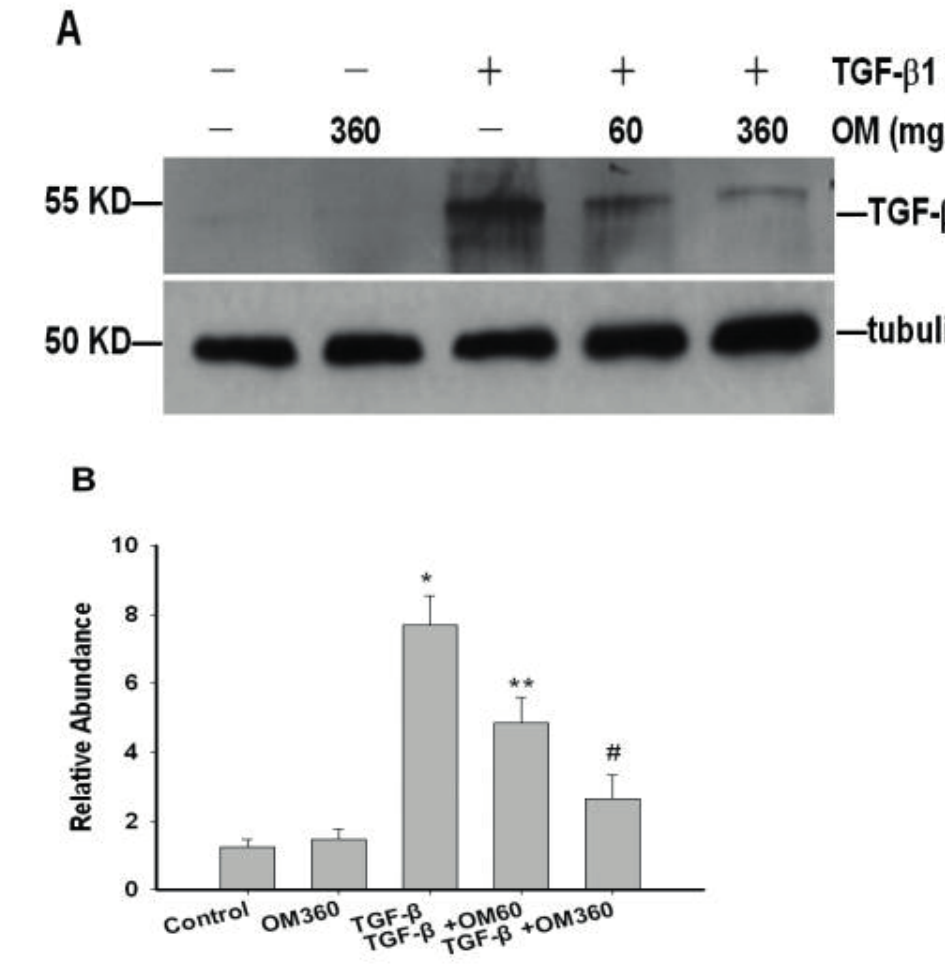
FIGURE 7 - OM treatment attenuated the expression of TGF- β RI in HK-2 cells activated by TGF- β 1 HK-2 cells were incubated with TGF- β 1 (5 ng/ml) or/and various concentrations of OM for 48 H. The protein expression of TGF- β RI in HK-2 cells was significantly increased after incubation with TGF- β 1 (5 ng/ml), while it was inhibited by OM in a dose-dependent manner (A). Graphical presentation of the relative abundance of TGF- β RI after normalization with α -tubulin control in different groups. The graph summarizes densitometric analysis of 3 independent technical experiments. *: P<0.05 vs. control group, **: P<0.05 vs. TGF- β 1 group, #: P<0.01 vs. TGF- β 1